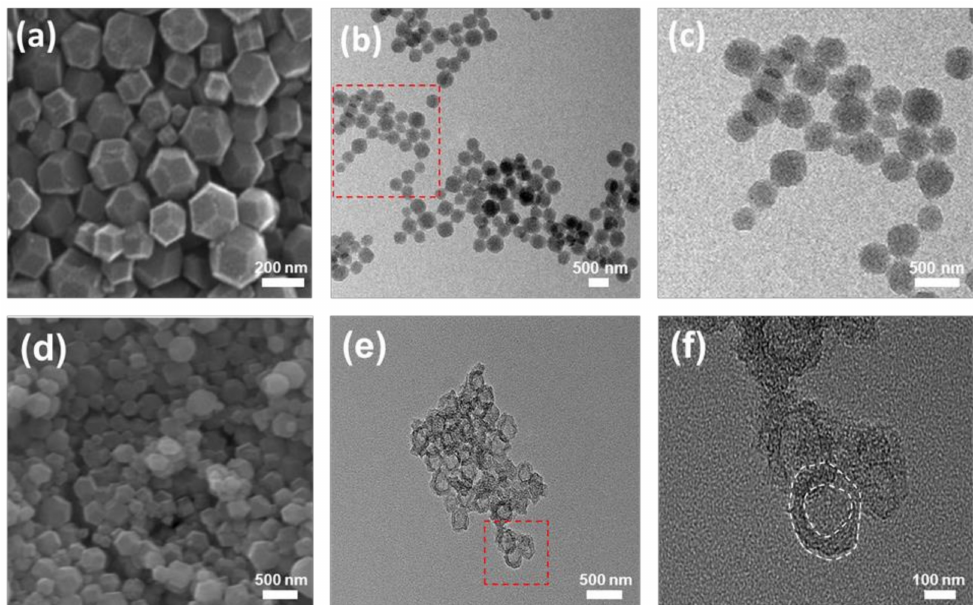
Figure 3. ( a – c ) SEM, TEM, and high-resolution TEM (HR-TEM) images of NC derived from ZIF-8, respectively; ( d – f ) SEM, TEM, HR-TEM images of HSNC, respectively. (The squared parts in ( b ) and ( e ) were magnified in ( c ) and ( f ),